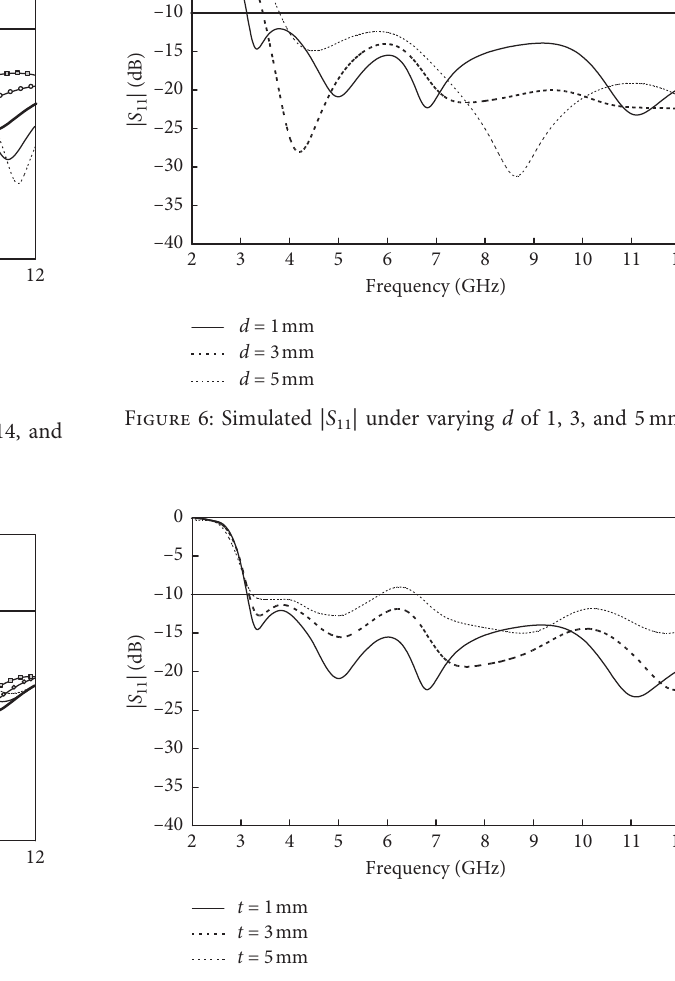
Figure 4: Simulated | S 11 | under varying b of 9, 10, 11, 12, and 13mm.